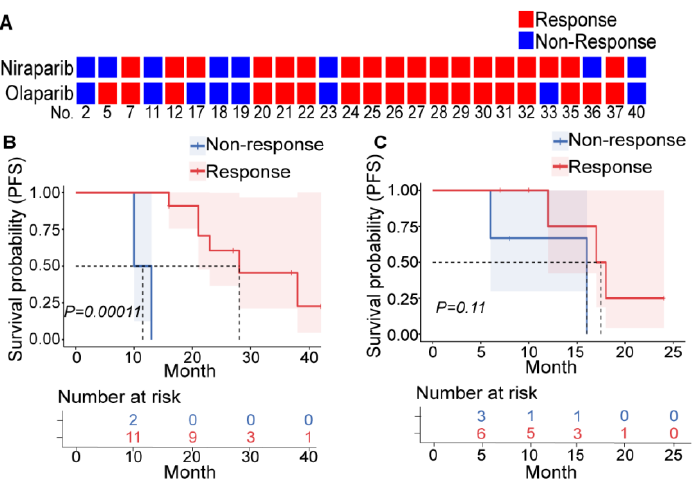
Figure 1. PDXs can reflect PARPi efficacy. ( A ) Results of the niraparib (upper row) and olaparib (lower row) susceptibility tests in PDXs derived from 26 patients. Each square represents a response to a drug (red: nonresponder; blue: responder), and each column represents a patient (the patient number is at the bottom). Patients who were treated with PARPis as first-line ( B ) or second-line ( C ) maintenance therapy were divided into the responder (red) and nonresponder (blue) groups according to the PDX drug sensitivity test, and the differences in PFS between these two groups were compared. The upper picture depicts the Kaplan–Meier curve and log-rank value between the responder and nonresponder groups. The lower table shows the number of patients who did not reach the endpoint at the corresponding time points in each